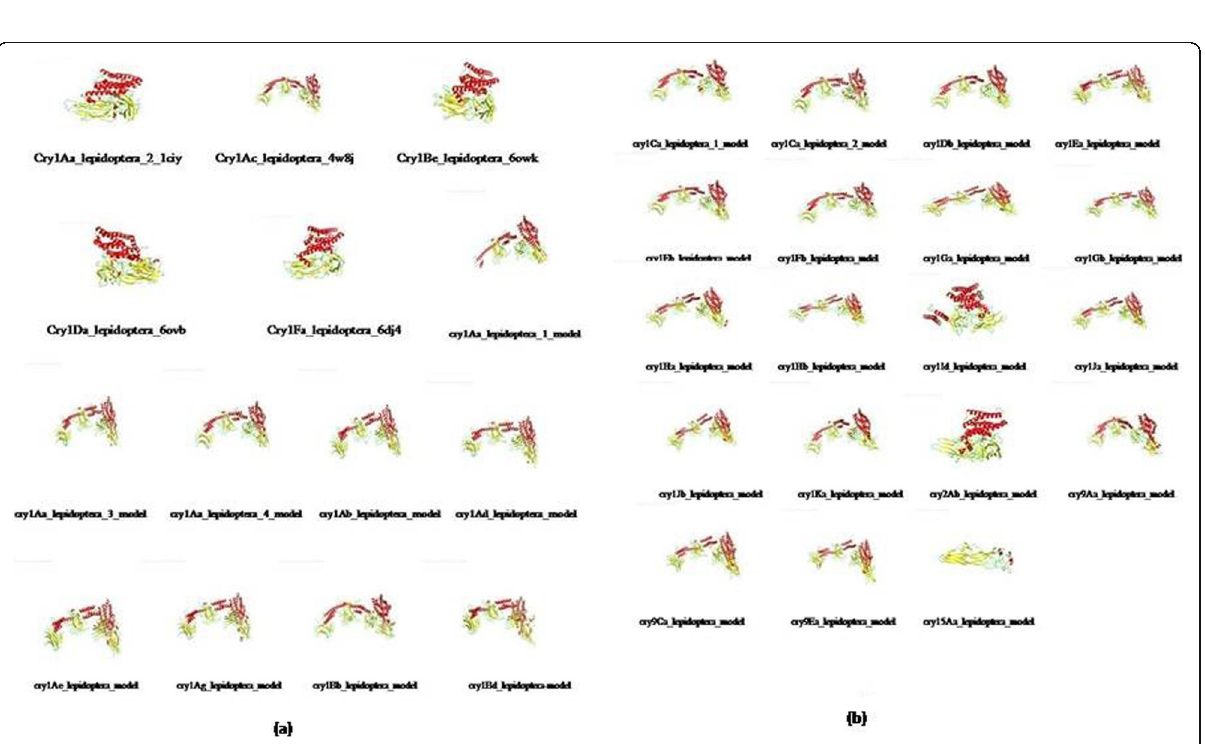
Fig. 6 a , b Experimental and predicted 3D structures (model) of Cry proteins having toxicity for Lepidoptera